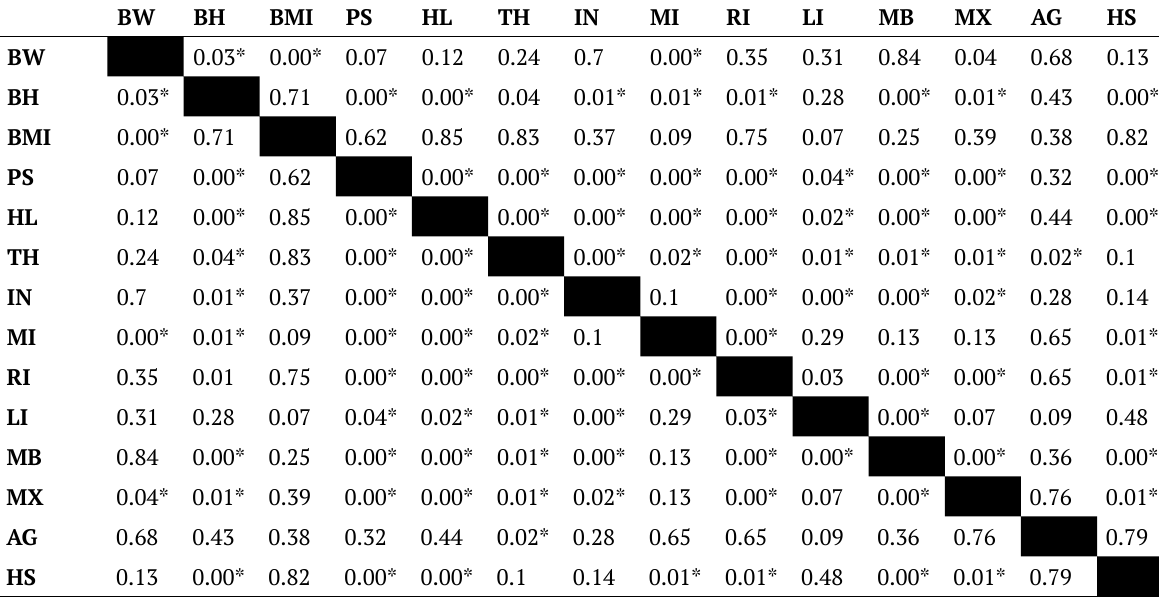
Table 2. Handgrip strength performance in recreational tenpin bowlers Parameters Left handgrip strength 21.51 ± 3.52 33.19 ± 5.35 0.00* Right handgrip strength 23.05 ± 3.44 34.79 ± 5.69 0.00* * Significant at the 0.05 level (2-tailed). Table 3. Pearson correlation coefficient matrix for anthropometric characteristics and handgrip strength in recreational tenpin